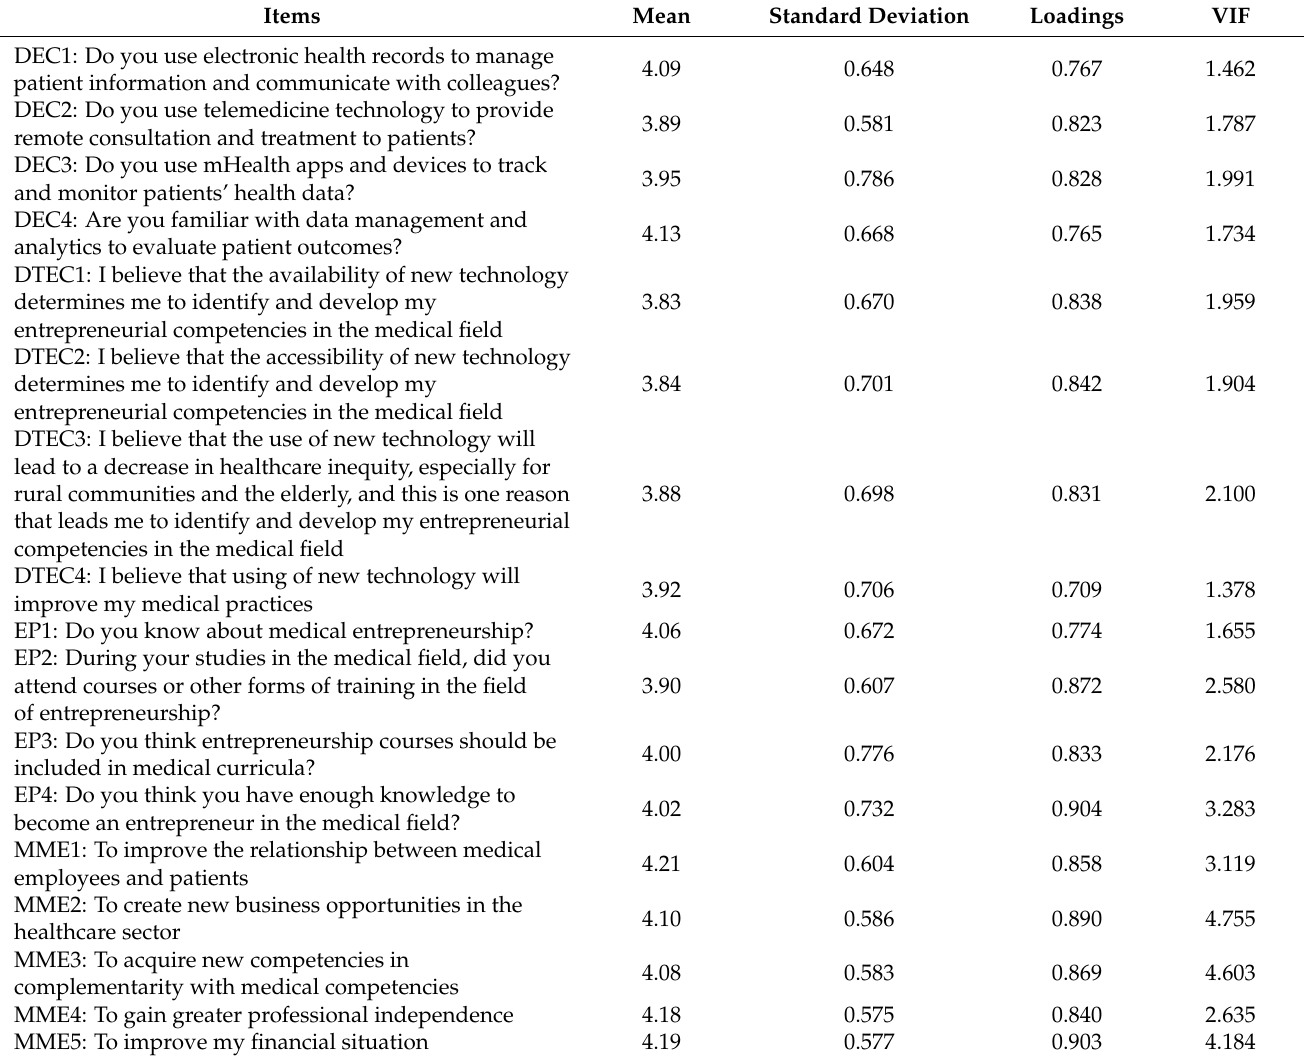
Table 2. Descriptive Statistics, Outer Loadings, and VIF for items of the